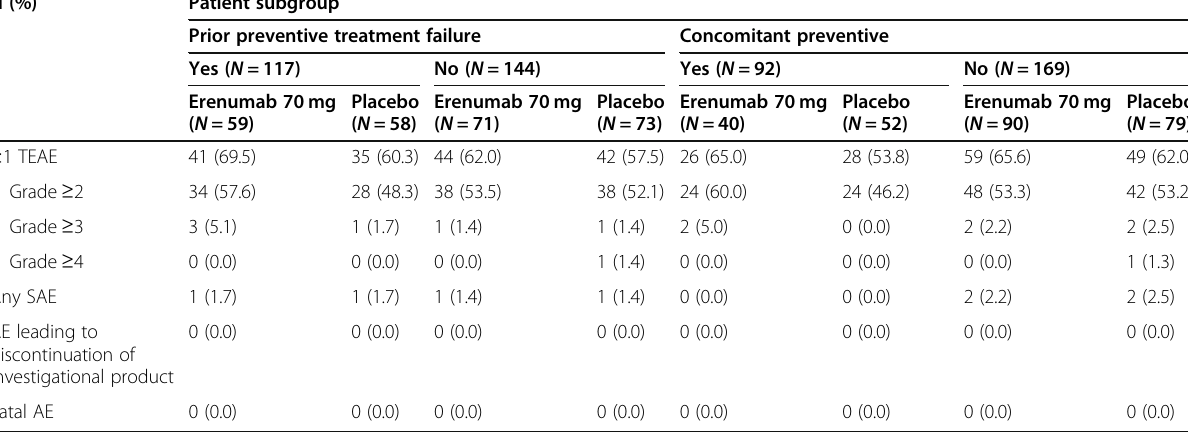
Table 2 Summary of adverse events N (%) Patient